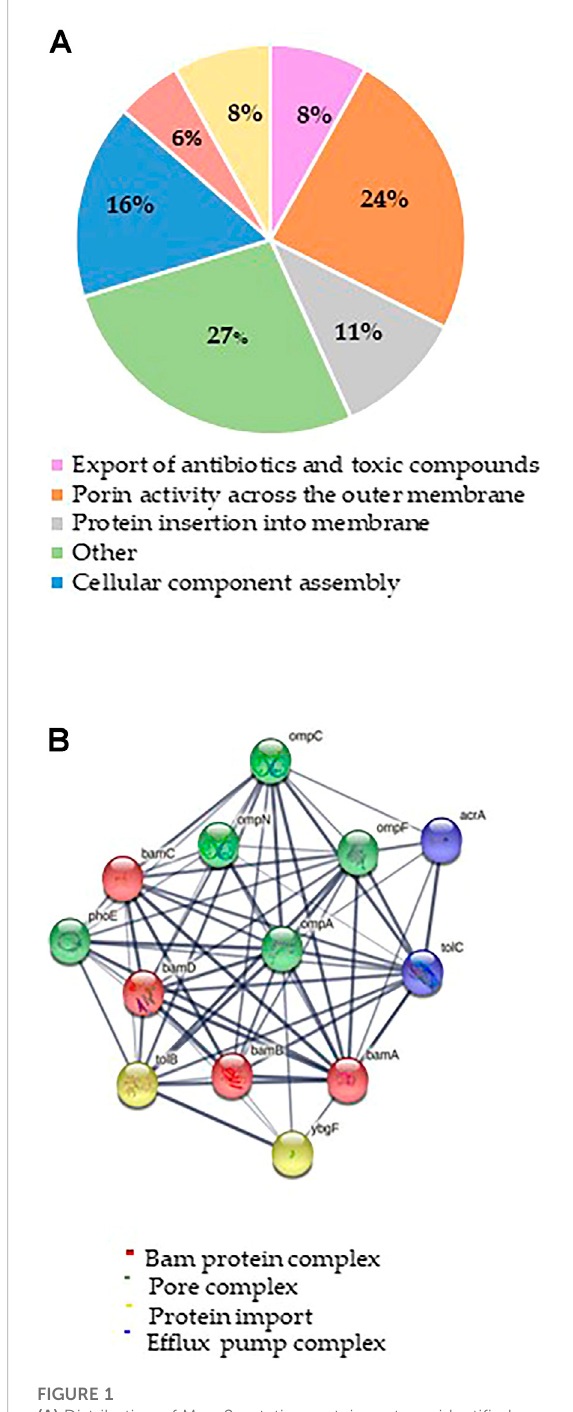
FIGURE 1 (A) Distribution of Mag-2 putative protein partners identi fi